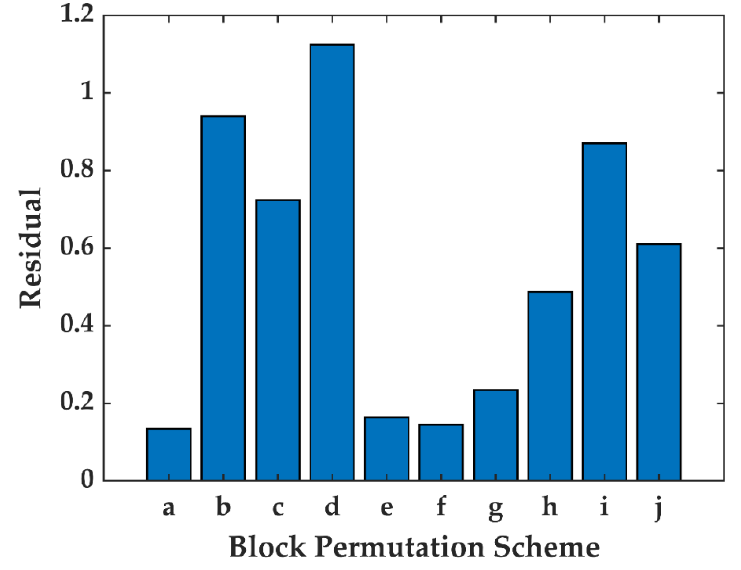
Figure 9. Residuals of face images involving scarves with different permutations [authors’ own pro- cessing].